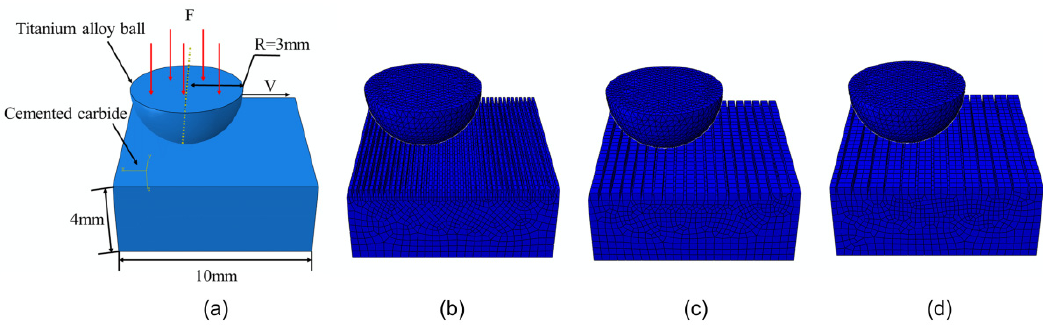
Figure 2. The simulation models of ( a ) G0, ( b ) G1, ( c ) G2, ( d ) G3.